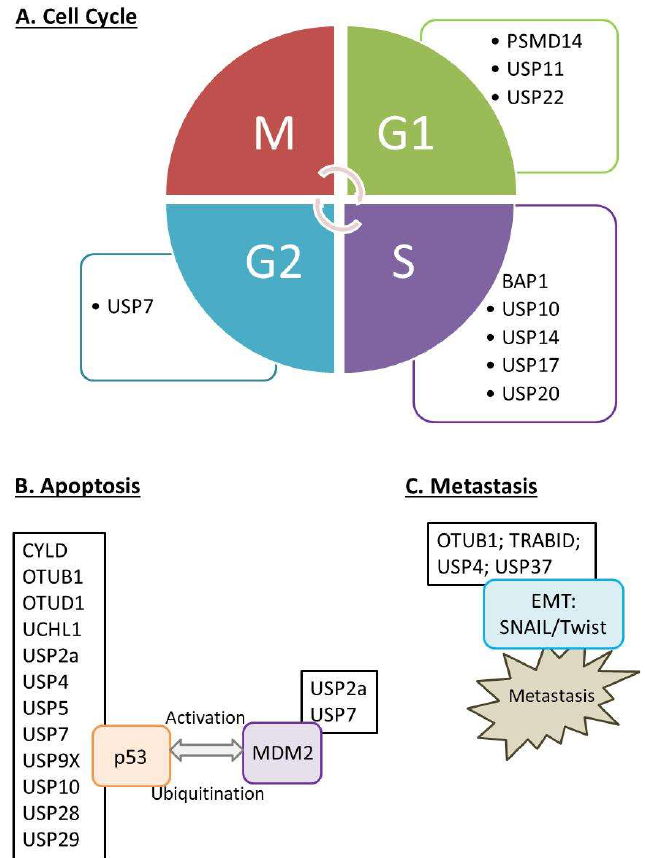
Figure 5. A brief summary of the roles of DUBs in this review. ( A ) DUBs affect cell cycle. Various